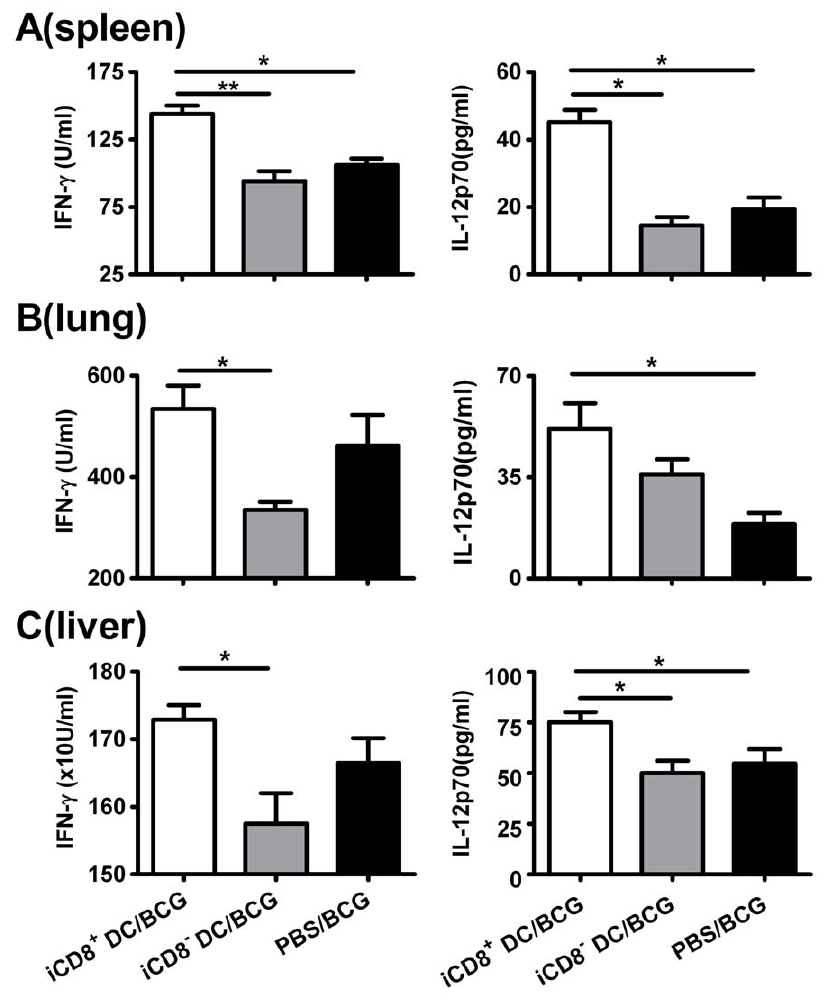
Figure 7. Effects of different DC subsets adoptive transfer on Th1-related cytokine production by recipient mice following challenge infection. A: The recipient mice (C57BL/6, n=4/group) of i.v. adoptive transferred iCD8 + DC or iCD8 - DC subsets and PBS treated control mice were challenged i.v. with BCG and sacrificed at day 21 post challenge as described in Materials and Methods. A, splenocytes were cultured at the concentration of 7.5 6 10 6 cells/well using HK-BCG as stimulator. Culture supernatants were harvested at 72 h and the cytokines were measured by ELISA. B&C, lungs and livers were homogenized in 10 ml cold protein-free D-PBS and centrifuged. The cytokines levels in the lung (B) and liver (C) were measured by ELISA. Data are presented as mean 6 SD of each group. One representative experiment of three independent experiments is shown. *p , 0.05; **, p , 0.01.